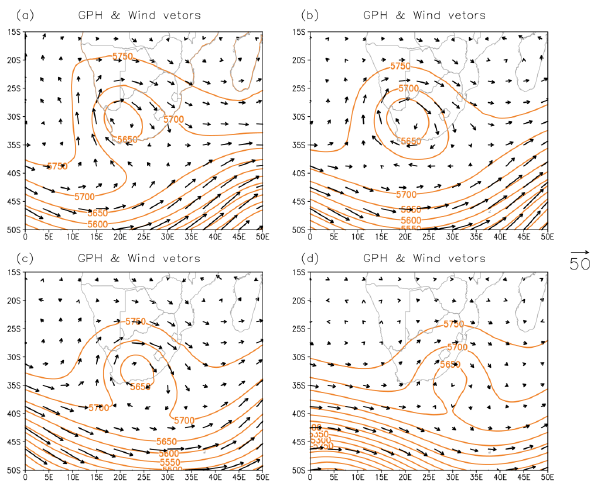
Figure 7. Geopotential height (m) and wind vector (m/s) at 500 hPa during ( a ) 22, ( b ) 23, ( c ) 24, ( d ) 25 April 2019.